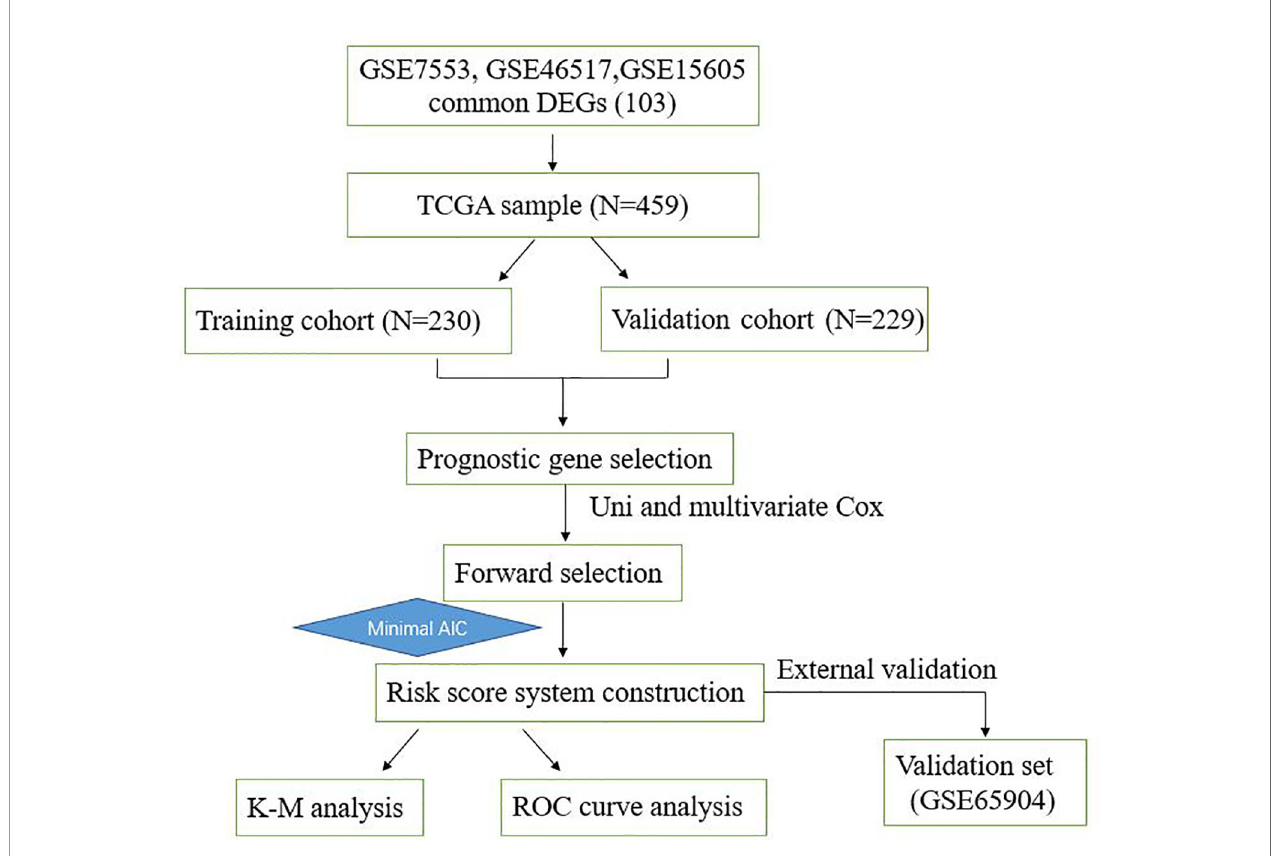
FIGURE 1 | Overall work fl ow describing the process used to develop and validate the prognostic model to predict prognostic